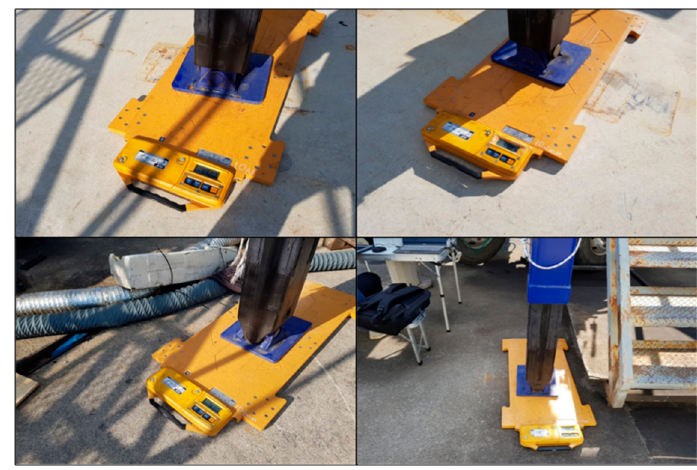
Figure 7. The outrigger axle installation in actual field test.